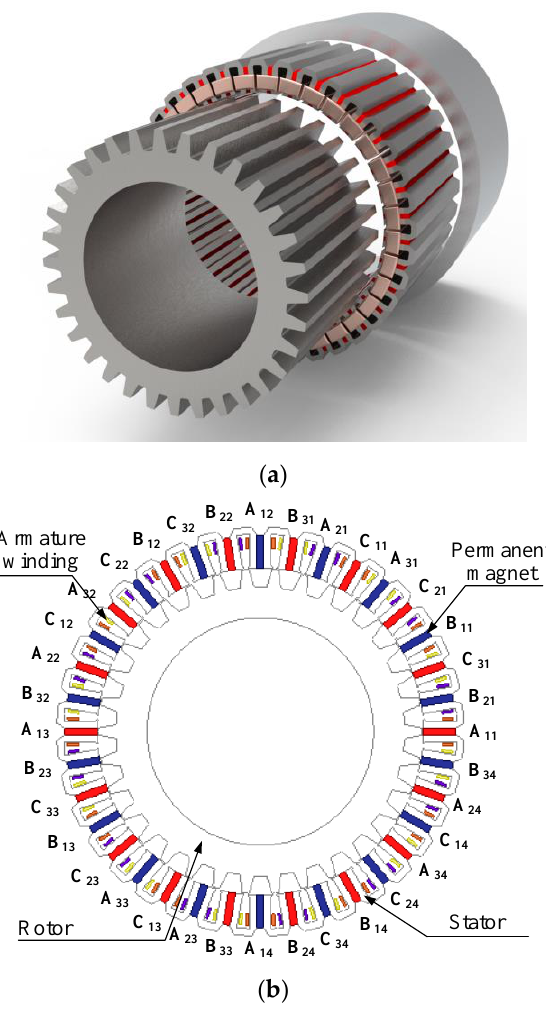
Figure 1. Structure of the nine-phase FSPM generator. ( a ) 3-D structure; ( b ) Sectional view. Table 1. Key design parameters of the nine-phase FSPM generator.